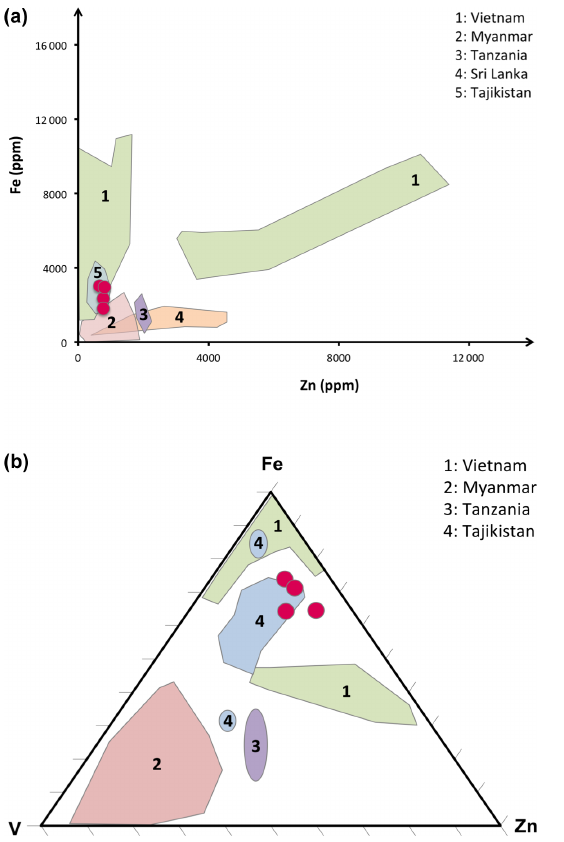
Figure 7. Chemical analyses of spinel from the reliquary crown of Namur plotted in the Fe vs. Zn (a) and Fe–Zn-V (b) diagrams pub- lished by Giuliani et al. (2017).